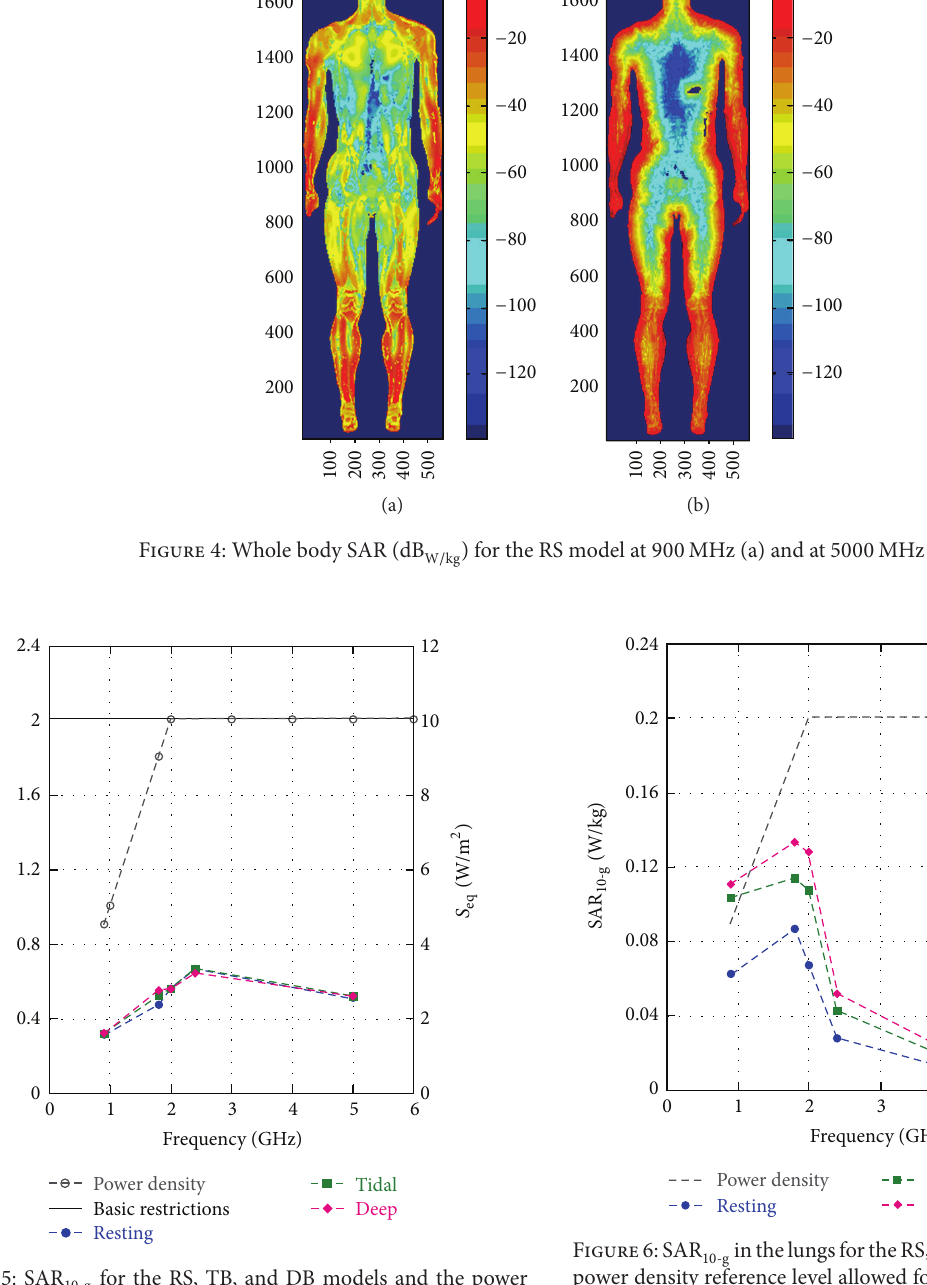
Figure 5: SAR 10 for the RS, TB, and DB models and the power -g density reference level allowed for general public in ICNIRP and IEEE 2005 guidelines.